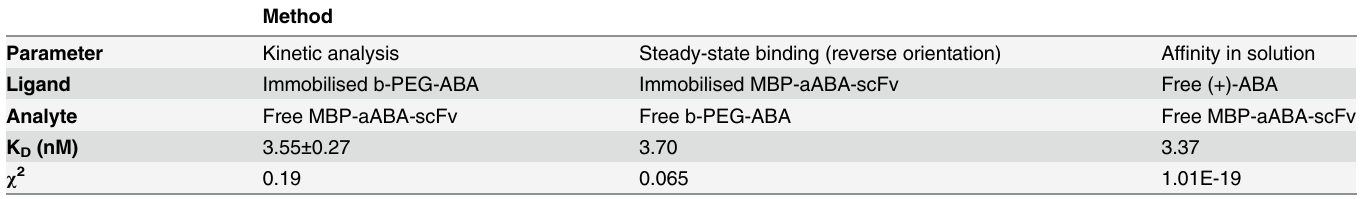
Table 1. Comparing values of affinity constant determined by surface (kinetic and equilibrium) and solution (equilibrium) assays for the scFv.